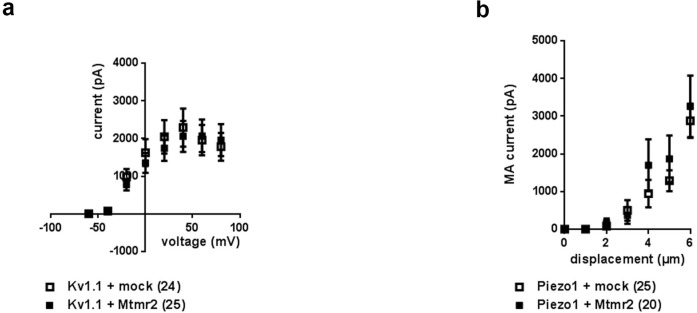
Mtmr2 overexpression does not influence Kv1.1- or Piezo1-mediated currents.(a) Voltage-current curves upon overexpression of Kv1.1 with Mtmr2 in HEK293 cells showed no significant difference compared to overexpression with mock (Kv1.1 + mock: n = 24 cells; Kv1.1+ Mtmr2: n = 25 cells; ns; 2-way ANOVA). (b) Stimulus-current curves of Piezo1-mediated MA currents upon co-overexpression of Piezo1 (Piezo1-753-myc-IRES-GFP [Coste et al., 2015]) with Mtmr2 compared to mock. No significant difference was observed among conditions (Piezo1 + mock: n = 25 cells; Piezo1 + Mtmr2: n = 20 cells; ns; 2-way ANOVA). The displacement threshold and inactivation time constant of Piezo1-MA currents remained unchanged upon overexpression with Mtmr2 (Supplementary file 1).